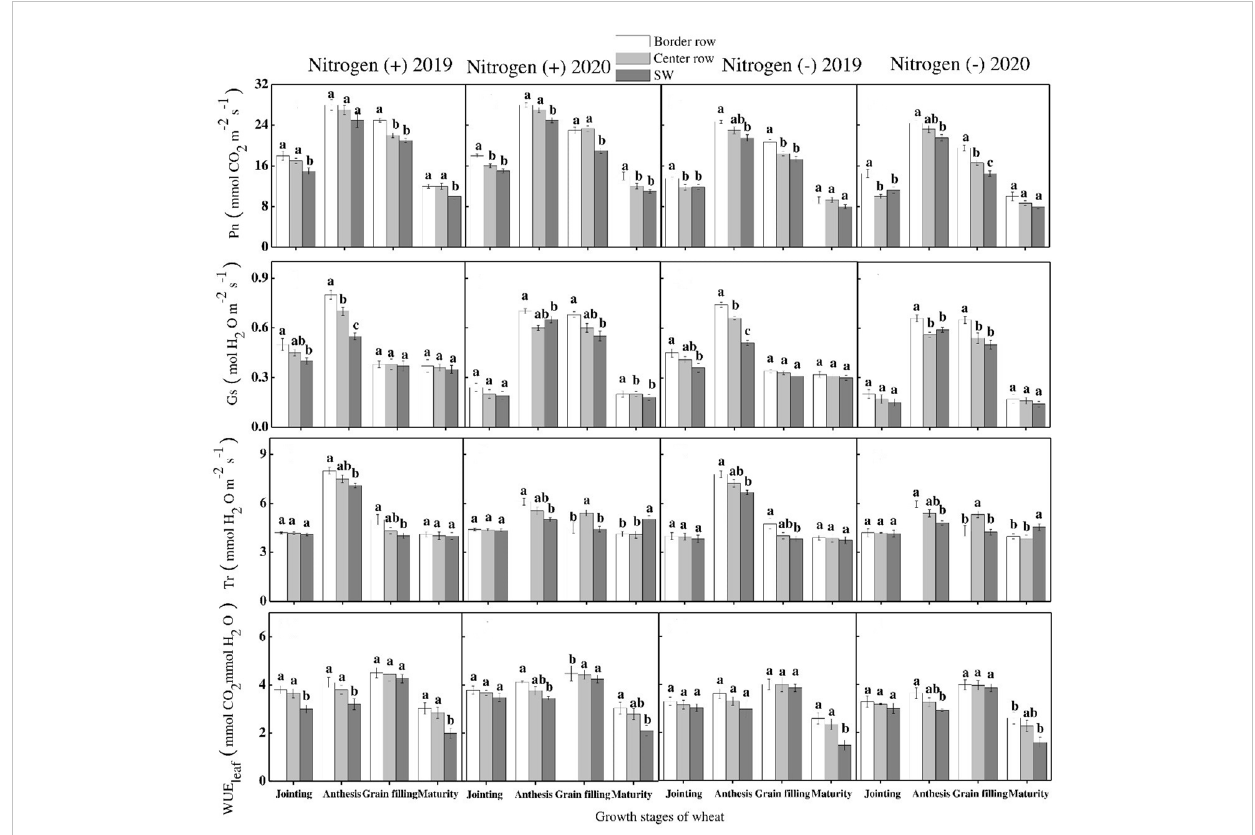
FIGURE 8 Photosynthesis rate (Pn), stomatal conductance (Gs), transpiration rate (Tr) and leaf water use ef fi ciency (WUEleaf) in the border-, center- and sole wheat (SW) crop at various growth stages under with- and without N application. Different letters on the top of each bar indicate signi fi cant differences among the various crop growth stages, as calculated by Tukey ’ s HSD test at P ≤